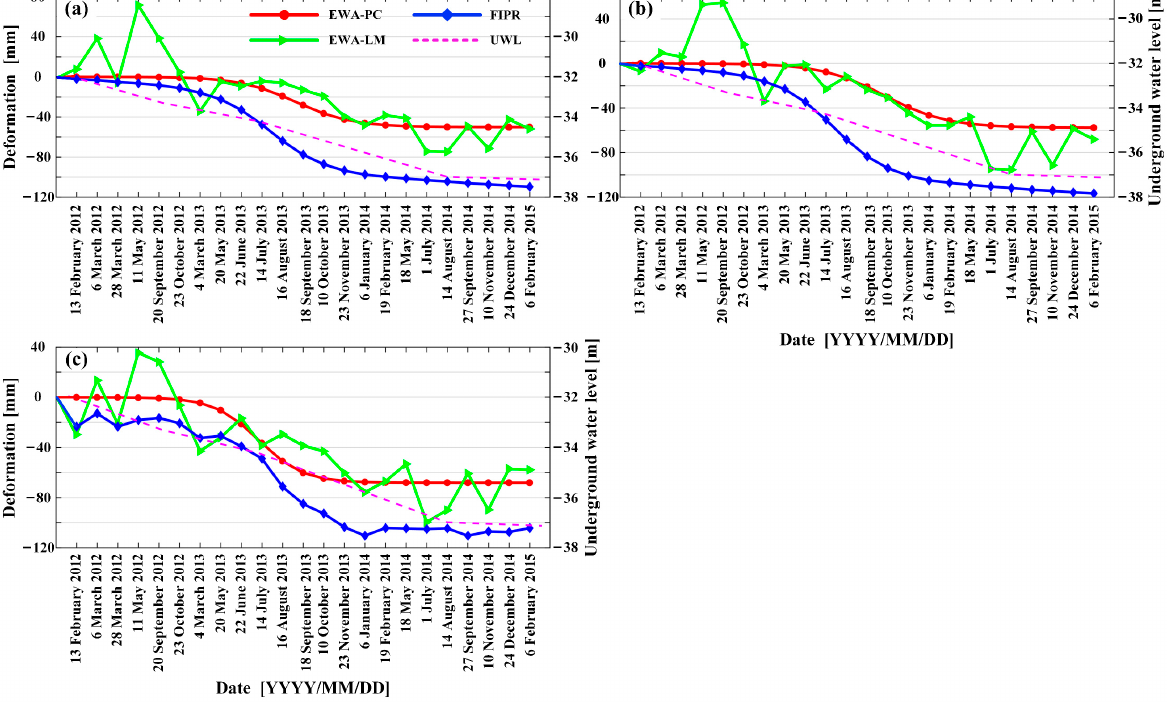
Figure 9. Correlation analysis between the time-series deformation results and the elevations of groundwater level (EWA-LM: linear model with equal weight accumulation; EWA-PC: Poisson curve with equal weight accumulation; UWL: elevation of groundwater level) at ( a ): P1; ( b ): P2; ( c ): P3.